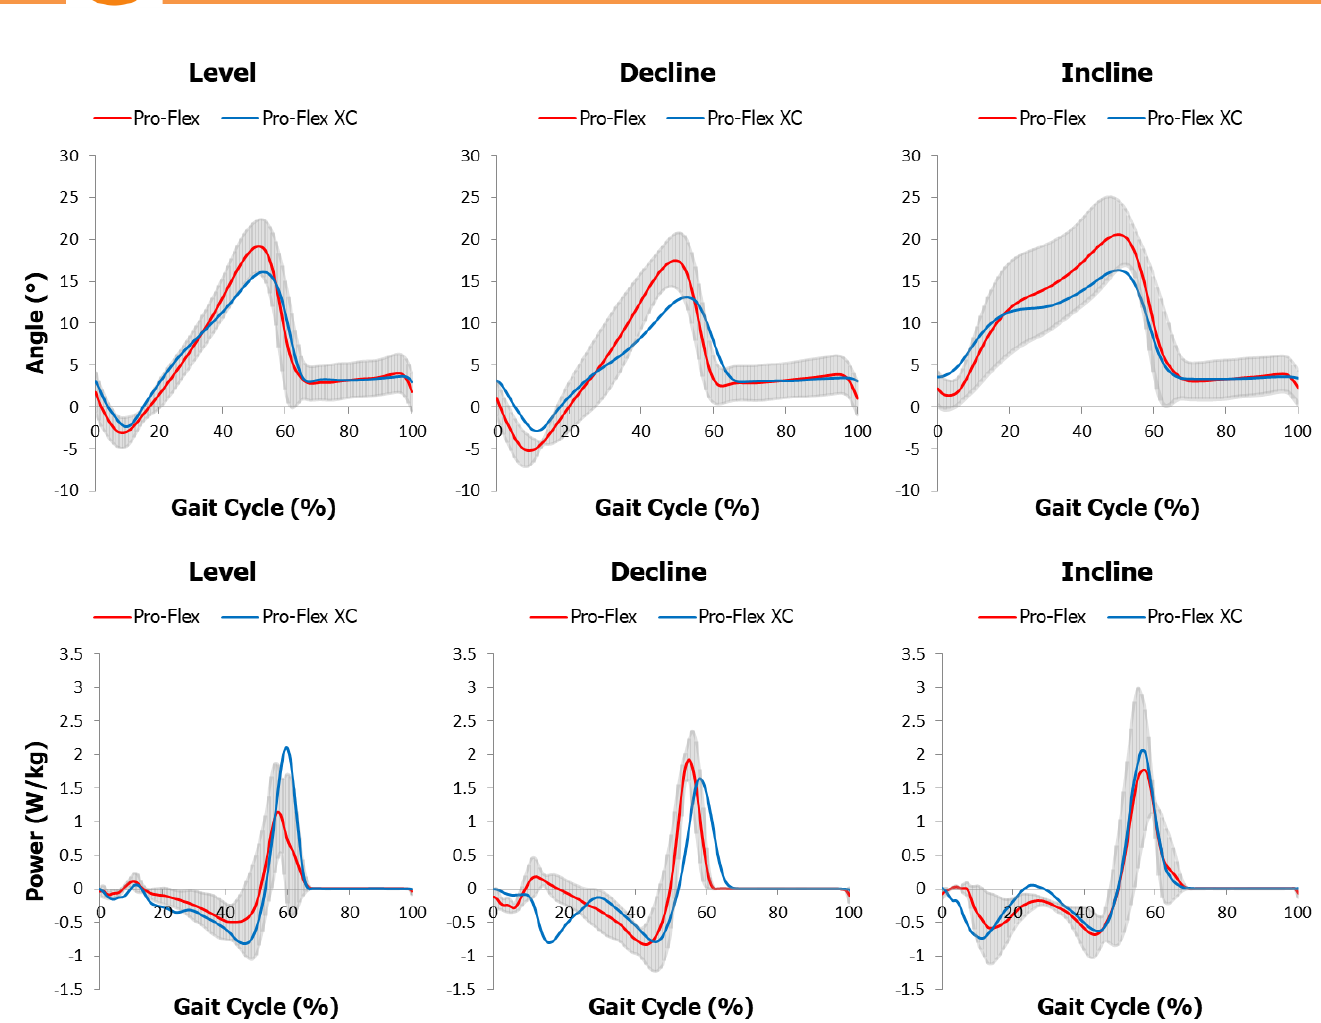
Figure 1. Mean prosthetic ankle angle and power during level, decline, and incline walking. Pro-Flex standard deviation in